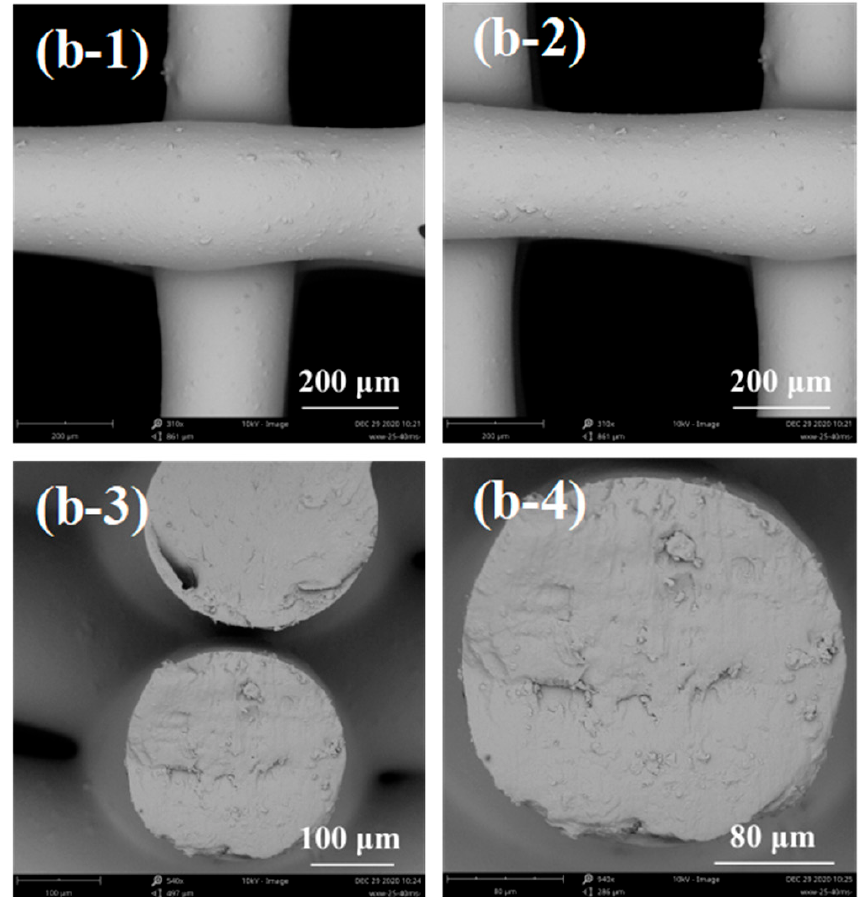
Figure 8. Images of the ( a ) uncured and ( b ) cured printed SiO 2 @TSPI composites; ( b-1 ) and ( b-2 ) SEM images of the cured printed SiO 2 @TSPI scaffold section; ( b-3 ) and ( b-4 ) SEM images of the cured printed SiO 2 @TSPI cross-section.